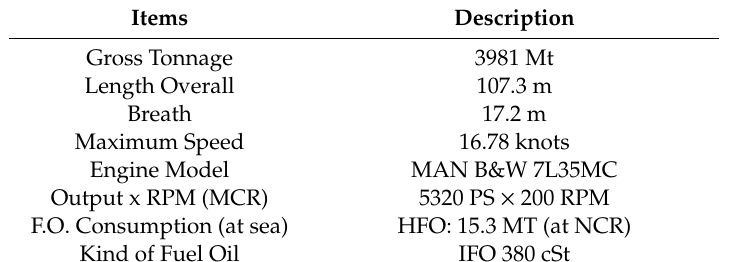
Table 1. Technical description of the container ship (M / V SUNNY SPRUCE).